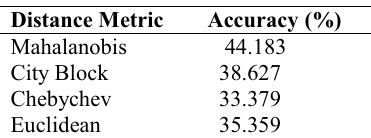
Table 8. Polynomial based distance metrics using Polygon area